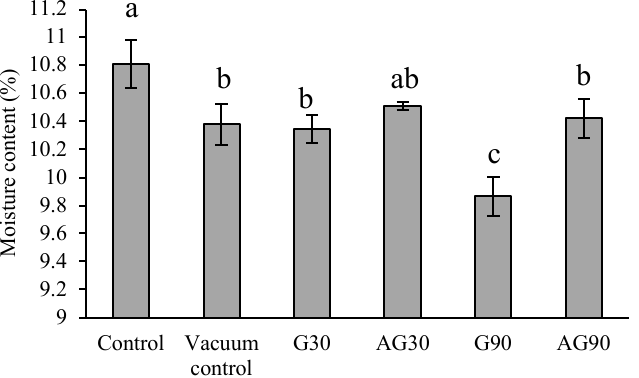
Figure 6. Moisture content in untreated (Control) seeds, seeds exposed to vacuum conditions (Vacuum control), and CP-treated seeds in the glow plasma regime for 30 (G30) or 90 s (G90), and in the afterglow regime for 30 (AG30) or 90 s (AG90). Displayed values are the mean ± SE of three replications. Different letters (a–c) indicate statistically significant differences among treatments according to Duncan’s test ( p < 0.05).